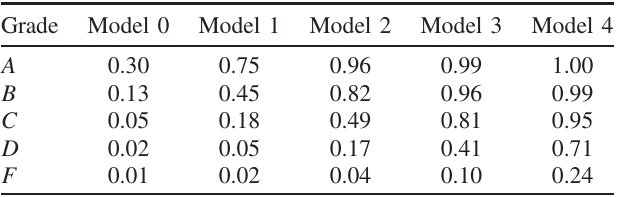
TABLE V. Participation rates for each final course grade based on models from Nissen et al. [2]. The model number represents the number of recommended practices to maximize student participation input into the final